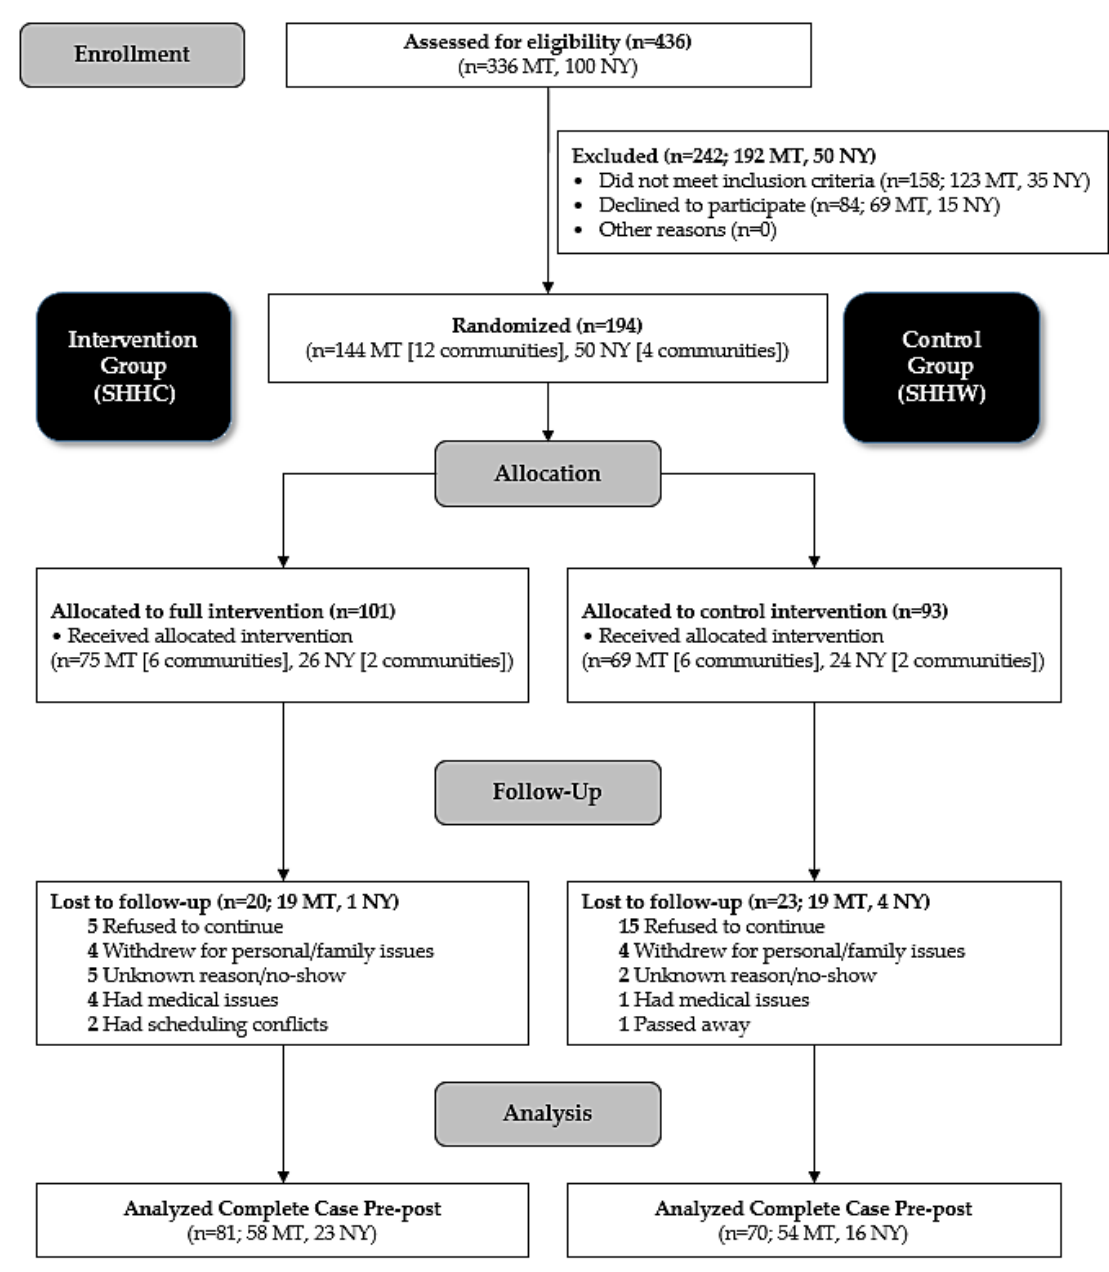
Figure 1. Study Flow: Strong Hearts, Healthy Communities, Montana and New York, 2015 – 2016.